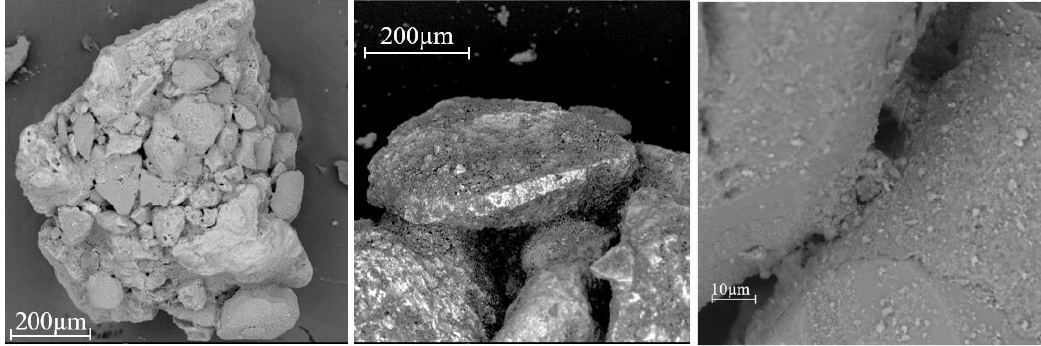
Fig. 3: Cemented aggregates of bauxite residue (Herza, 2020) Figure 3. Cemented aggregates of bauxite residue [9].